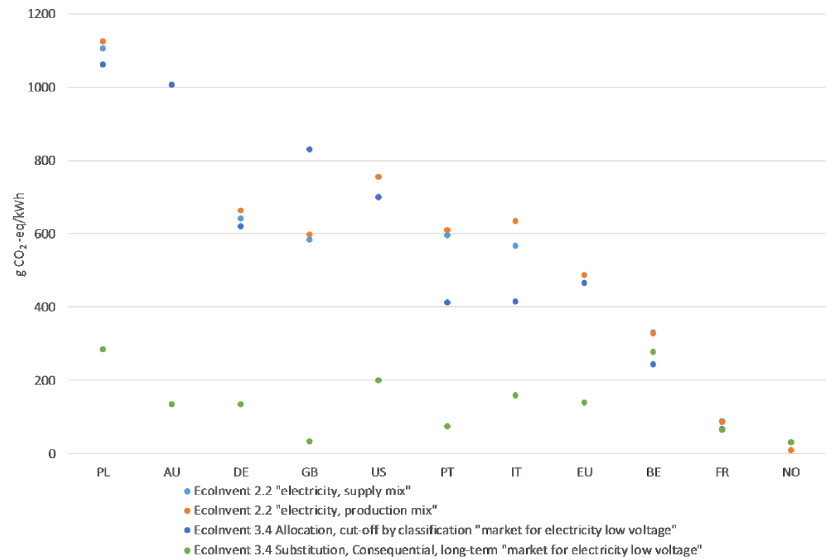
Figure 4. Climate change of 1 kWh of different electricity mixes provided at EcoInvent database. Characterisation model: IPCC 2007; Characterisation factor: GWP 100a. Time period: 2004 for